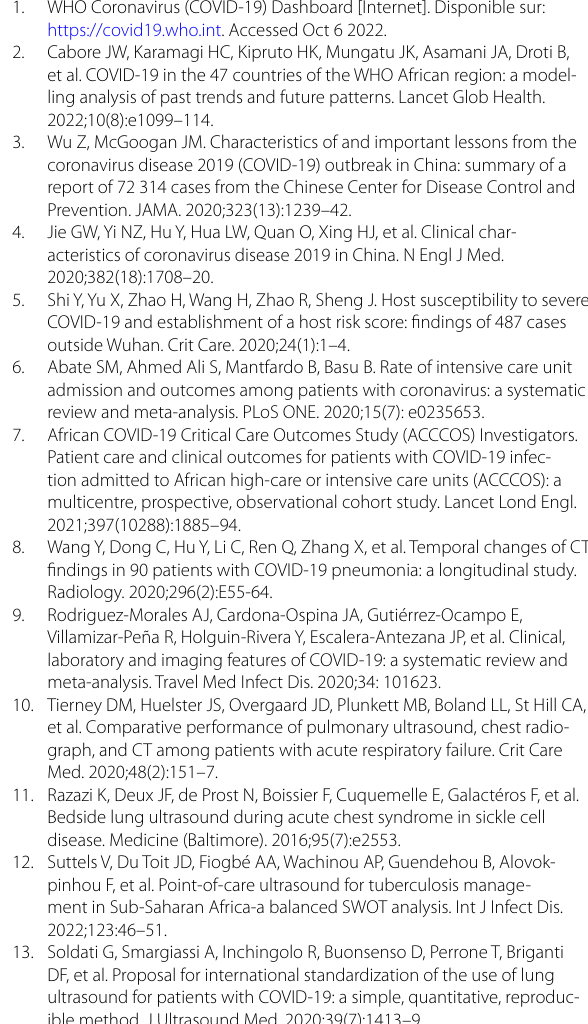
Additional file 1: Table S1. Description of the quadrants considered for ultrasound examination. Table S2. Sociodemographic characteris-